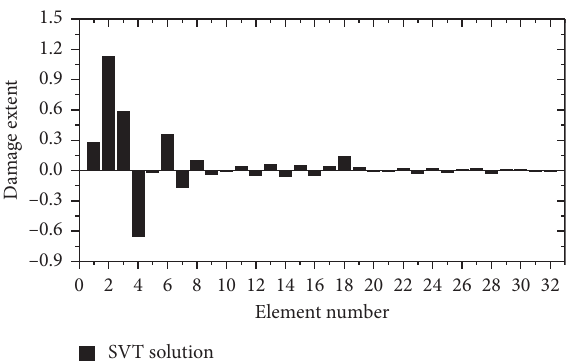
Figure 6: Damage assessment result by the SVT when elements 6 and 18 are damaged.